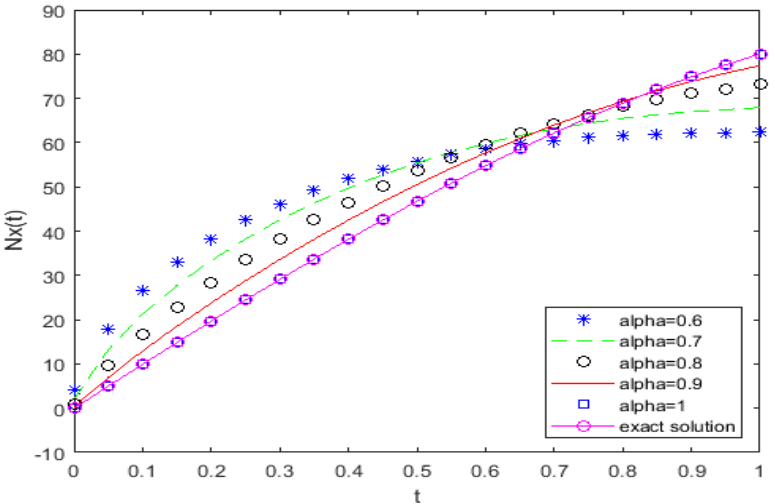
Figure 20. Behaviour of the approximate solution of 𝑁 (cid:3051) (𝑡) at 𝛼 = 0.6,0.7,0.8, 0.9 and 1 , with parameters: 𝑤 (cid:2868) = 1 , 𝑇 (cid:2869) = 1 , 𝑇 (cid:2870) = 20, 𝑎 = 1, 𝑏 = 1 .